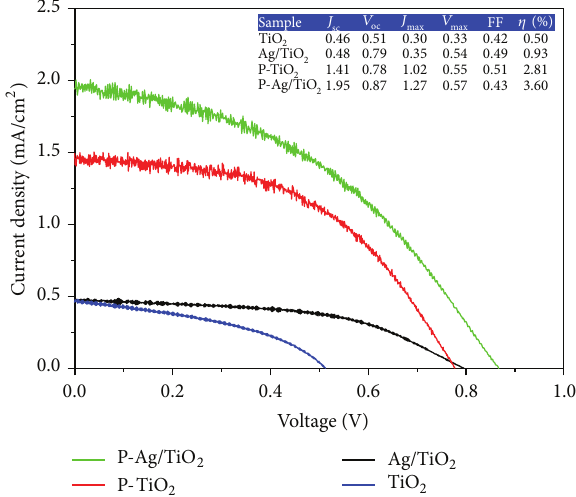
Figure 10: Density-voltage ( 𝐽 - 𝑉 ) curves of TiO 2 , Ag/TiO 2 , P-TiO 2 , and P-Ag/TiO 2